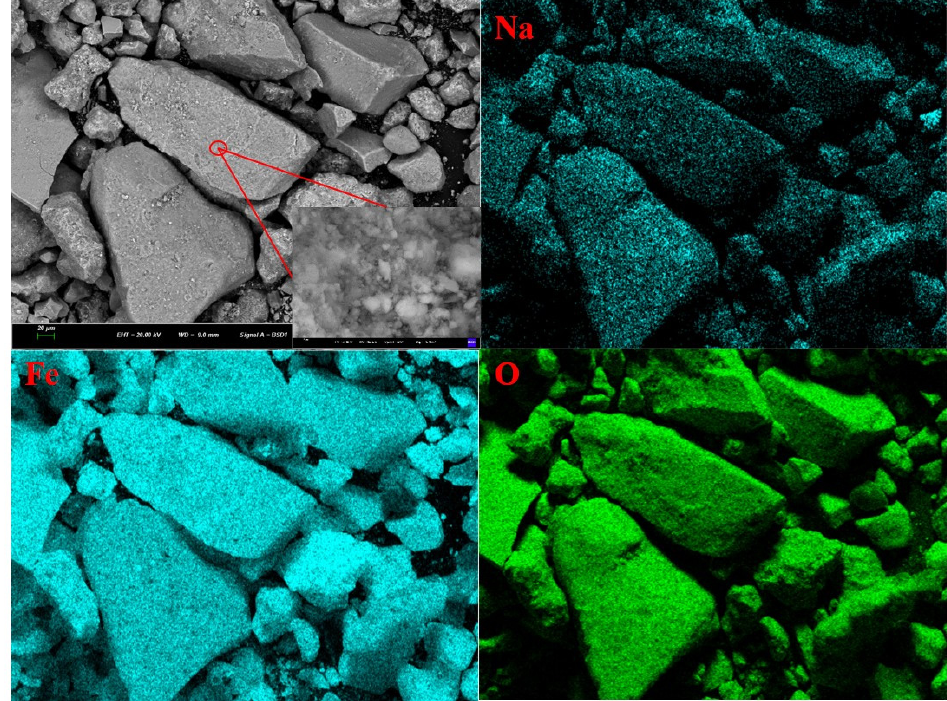
Figure 9. SEM images and EDS element map of the reduction product (2.0% NaOH).